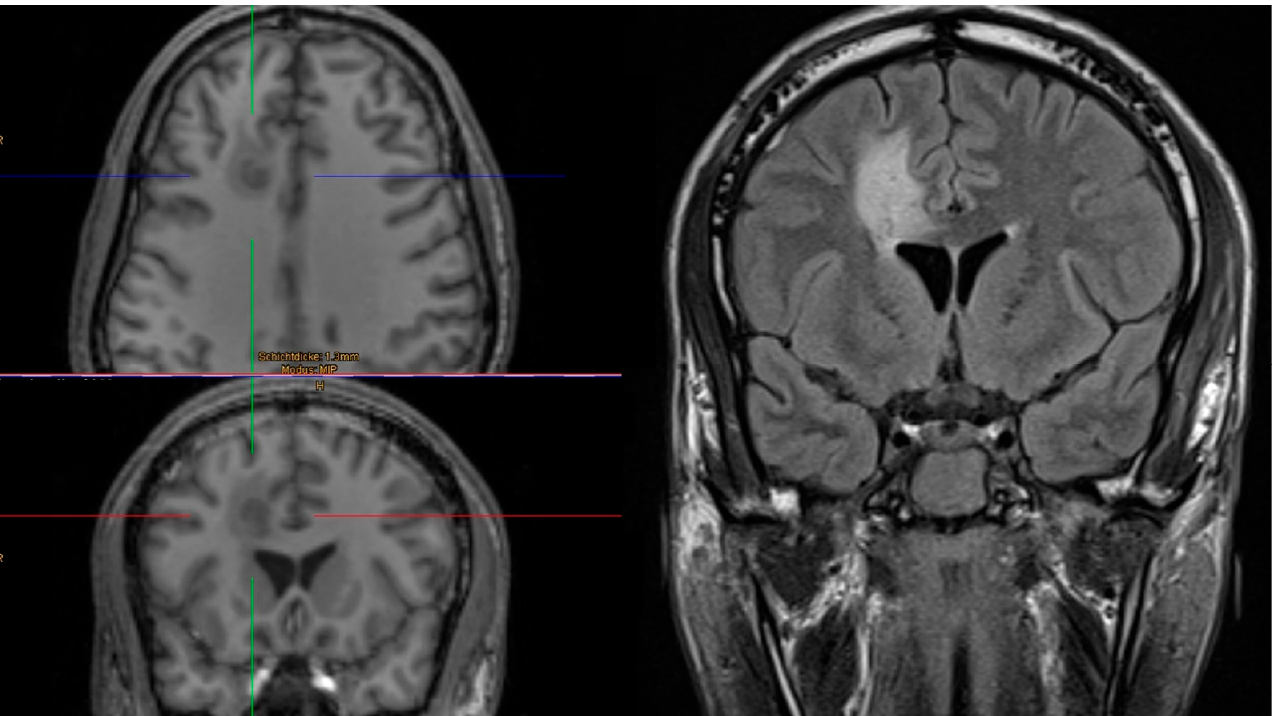
Figure 3. Axial T1-weighted MRI with corresponding coronal imaging showing a lesion in right frontal lobe. Coronal FLAIR demonstrating local edema. The patient underwent 3 MRI examinations with an ICP probe in situ.